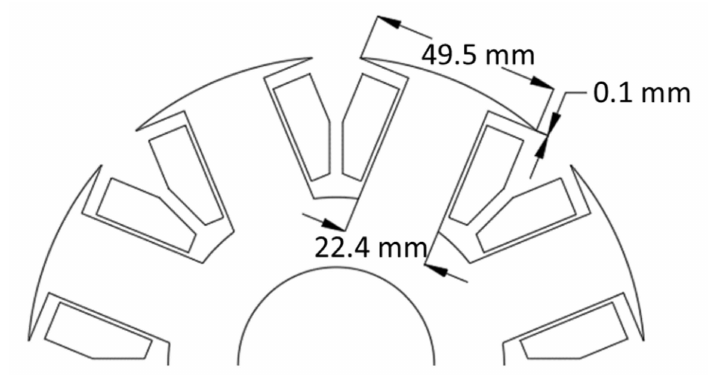
Figure 9. Rotor pole structure (optimal